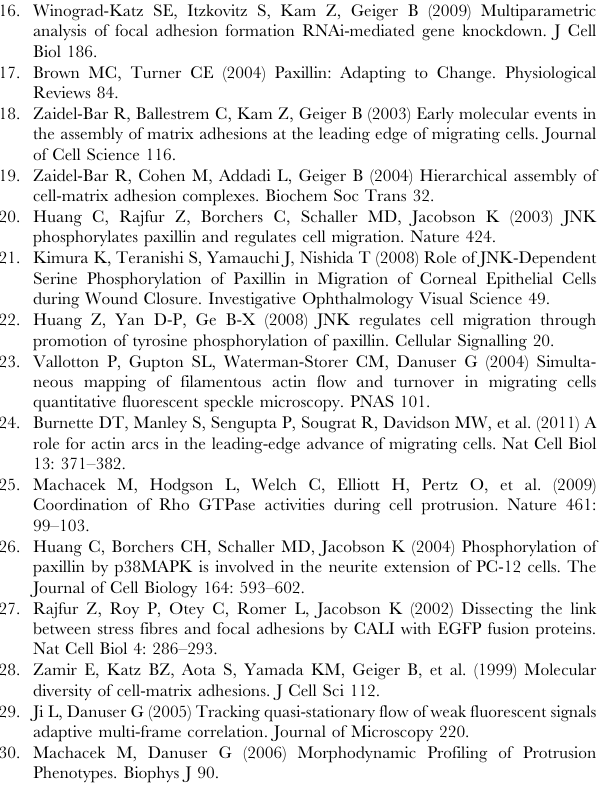
Video S1 Example movie showing the results of track- ing the EGFP-Paxillin labeled adhesions. The left panel shows the normalized raw experimental data, while the right hand side shows each adhesion outlined in a different color. As the movie plays, the highlighting color remains the same for each unique adhesion. The scale bar is 10 m m. (MOV) Video S2 Example movie showing the results of track- ing the EGFP-PaxillinS178A labeled adhesions. The left and right panels are the same as in Video S1. The scale bar is 10 m m. (MOV) Video S3 Example movie showing the results of track- ing the EGFP-FAK labeled adhesions. The left and right panels are the same as in Video S1. The scale bar is 10 m